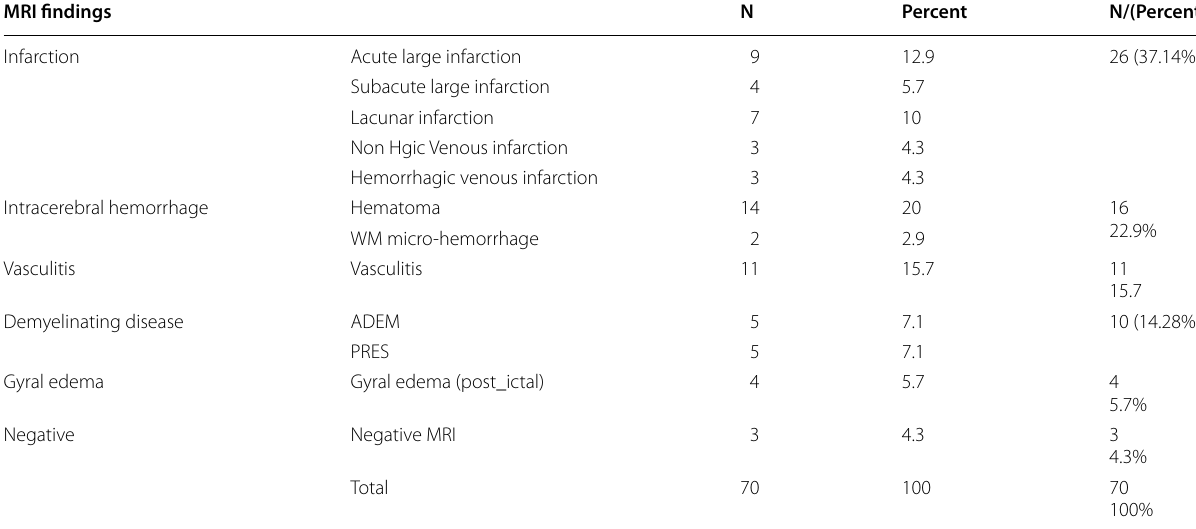
Table 4 The MRI findings of neurological manifestations in patients with COVID-19 MRI findings